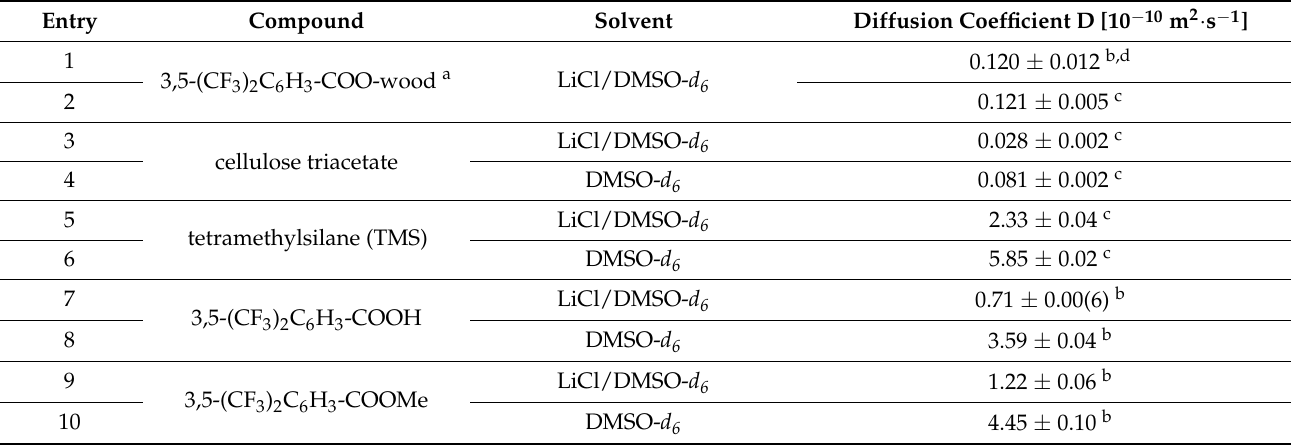
Table 1. Diffusion coefficients of chemically modified wood, suitable precursors, and reference